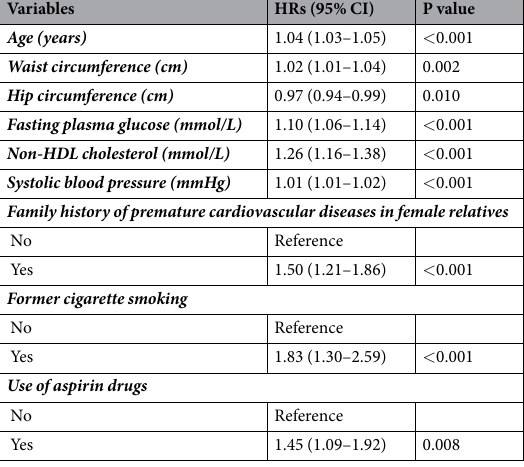
Table 3. Multivariate Cox regression analysis of factors associated with CHD incidence in male population (n = 2,805), Tehran Lipid and Glucose Study (1999–2012). Cox proportional hazard regression model with stepwise selection method was used to calculate hazard ratios (HRs) and 95% confidence interval (CI), and Akaike information criteria (AIC) was used for model selection